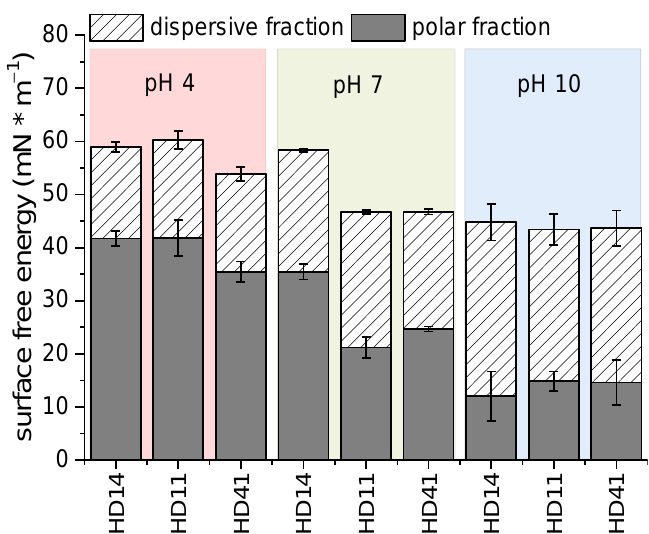
Figure 6. Surface free energy of the pp d-HD films stored in different pH solutions.